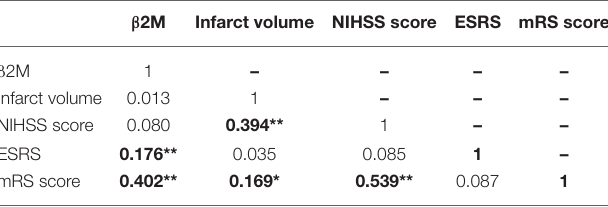
TABLE 2 | Correlation of β 2-microglobulin ( β 2M) with infarct volume, National Institute of Health Stroke Scale (NIHSS) score, Essen Stroke Risk Score (ESRS), and modified Rankin Scale (mRS score) ( N = 205).